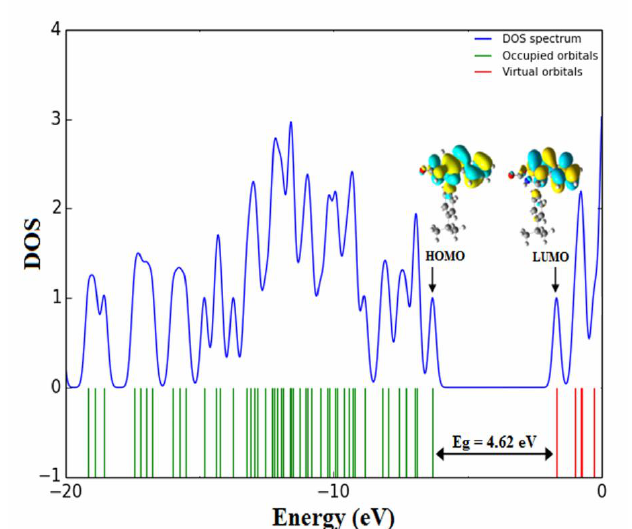
Fig. 5. Calculated DOS plots of 4i structure